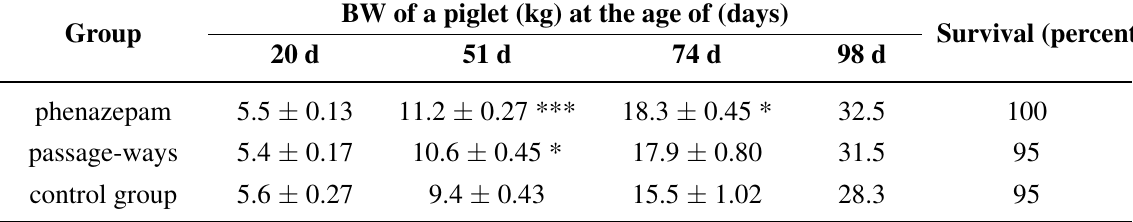
Table 1. Least squares means ± SEM for influence of phenazepam or passageways in Experiment 1. Weanling pig body weights and survival rate varied by group and age. N = 20 weanling pigs per group. BW of a piglet (kg) at the age of Group